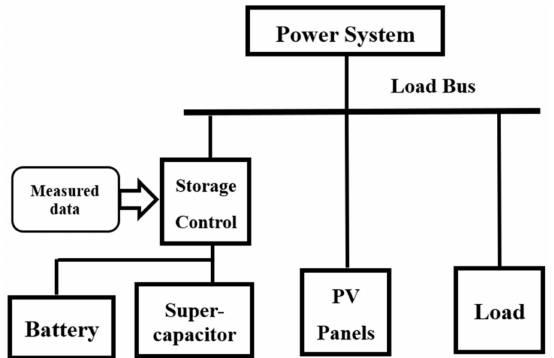
Figure 2. Generic schematic of ideal hybrid photovoltaic (PV)-storage